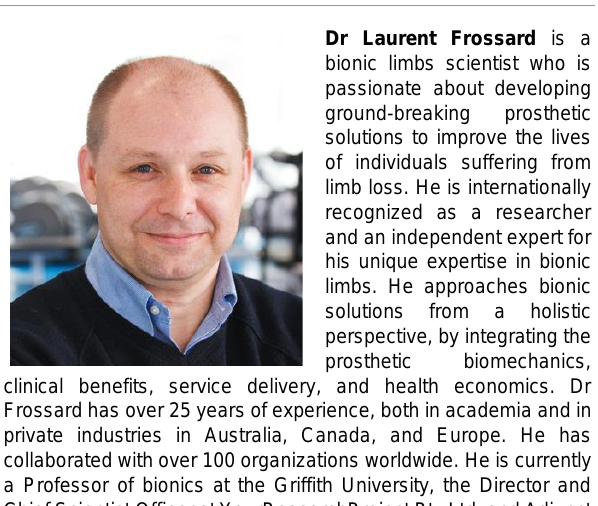
Frossard L. A preliminary cost-utility analysis of the prosthetic care innovations: basic framework. Canadian Prosthetics & Orthotics Journal. 2021; Volume 4, Issue 2, No.10.